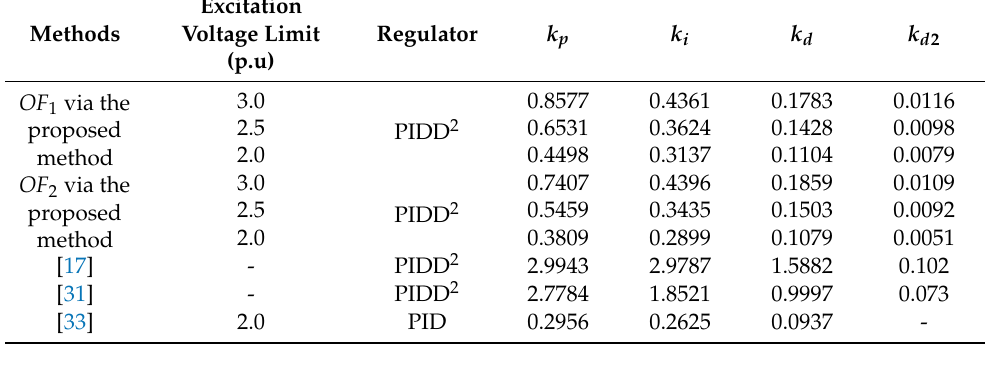
Table 2. Comparison of the results obtained using the proposed and presented algorithms in the